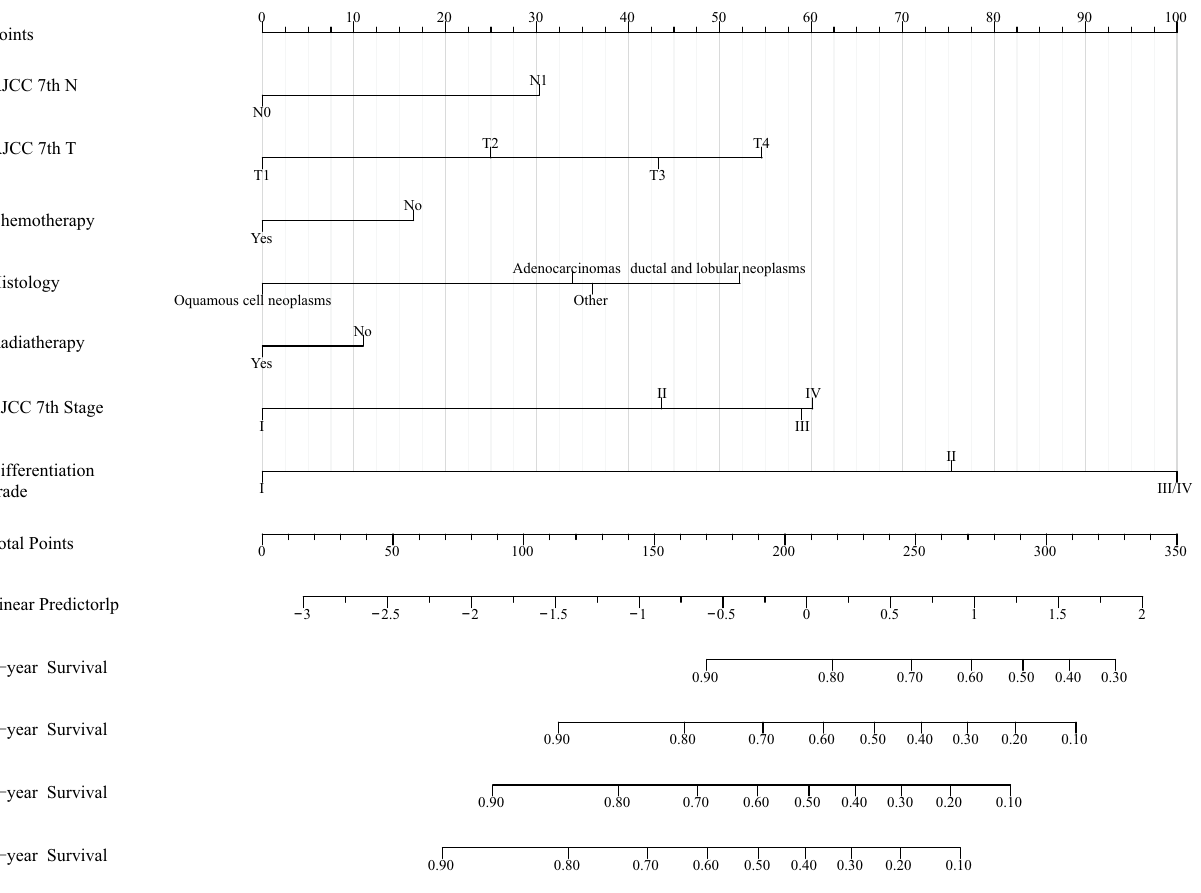
Figure 3. Nomogram to estimate the risk of prognosis for pancreatic cancer after